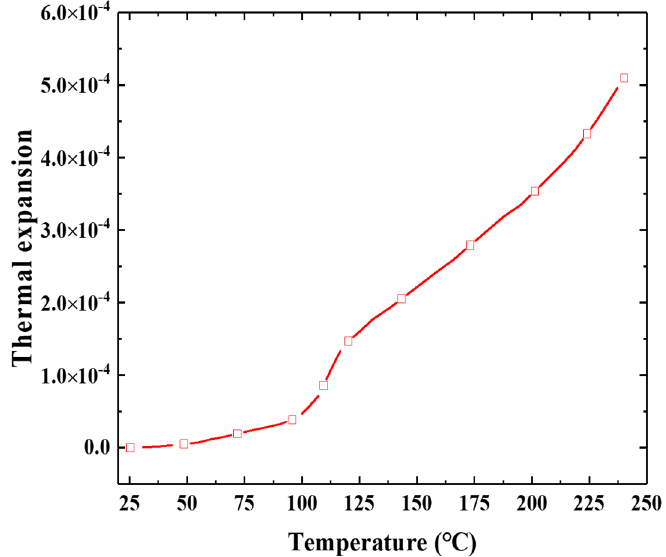
Figure 4. Thermal expansion coefficients of E-SMP at different temperatures.